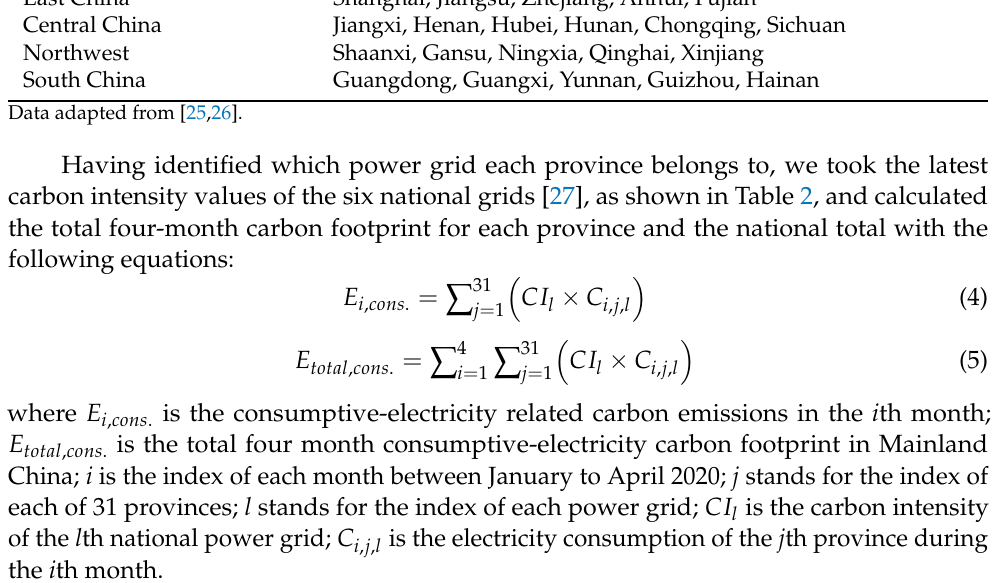
Table 2. GHG Burden for China’s National and Regional Grids. Grids North Northeast Northwest Central East South Carbon Intensity (gCO 2 /kWh) 1066 1014 833 751 836